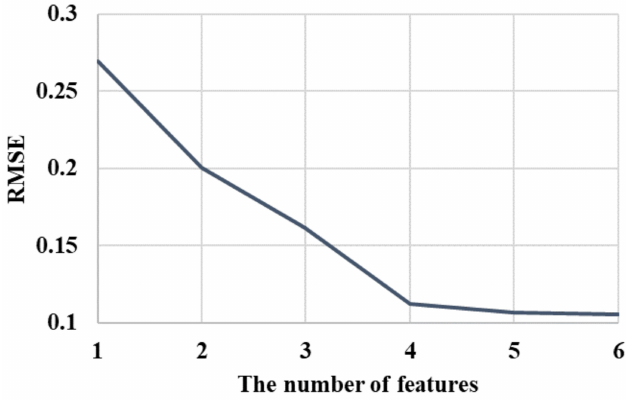
Figure 5. RMSE variation curve of different characteristic